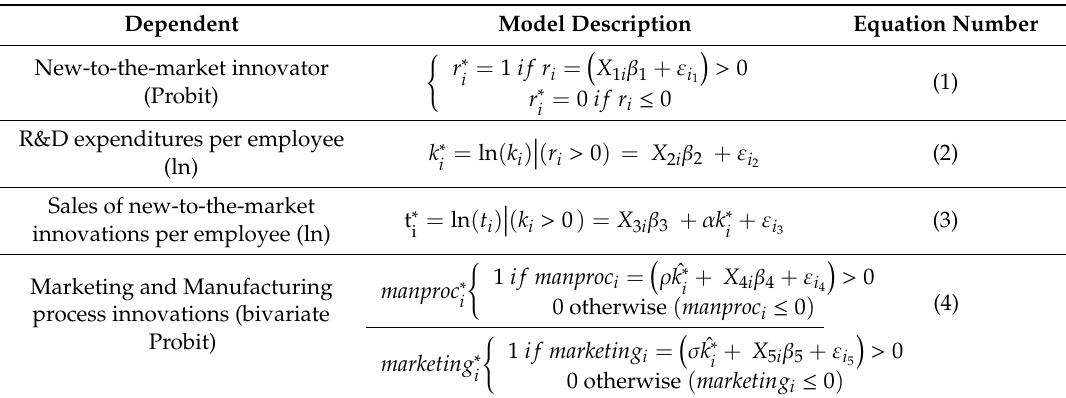
Table 3. Innovation model used for